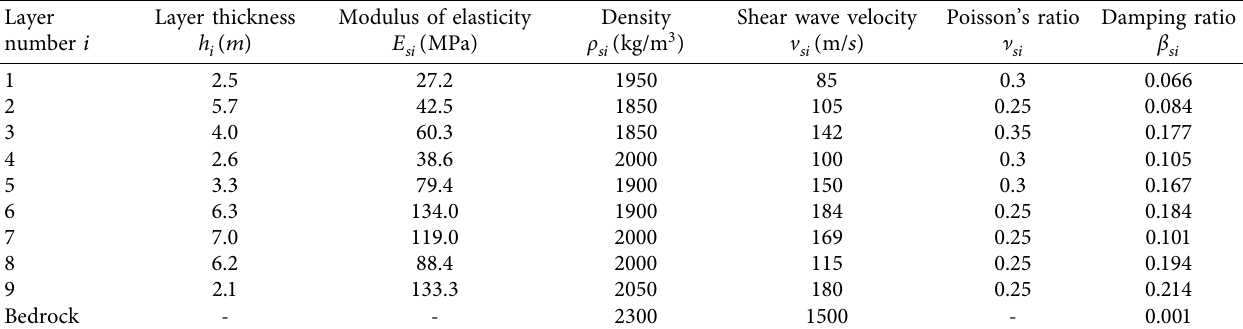
Table 2: Characteristic parameters of soil